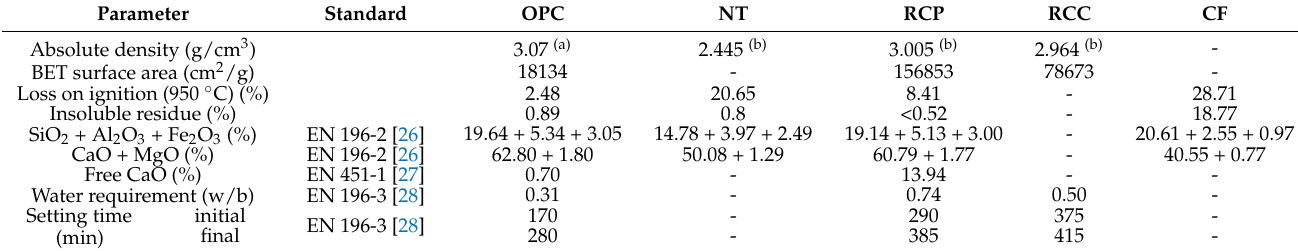
Table 2. Properties of the cements and